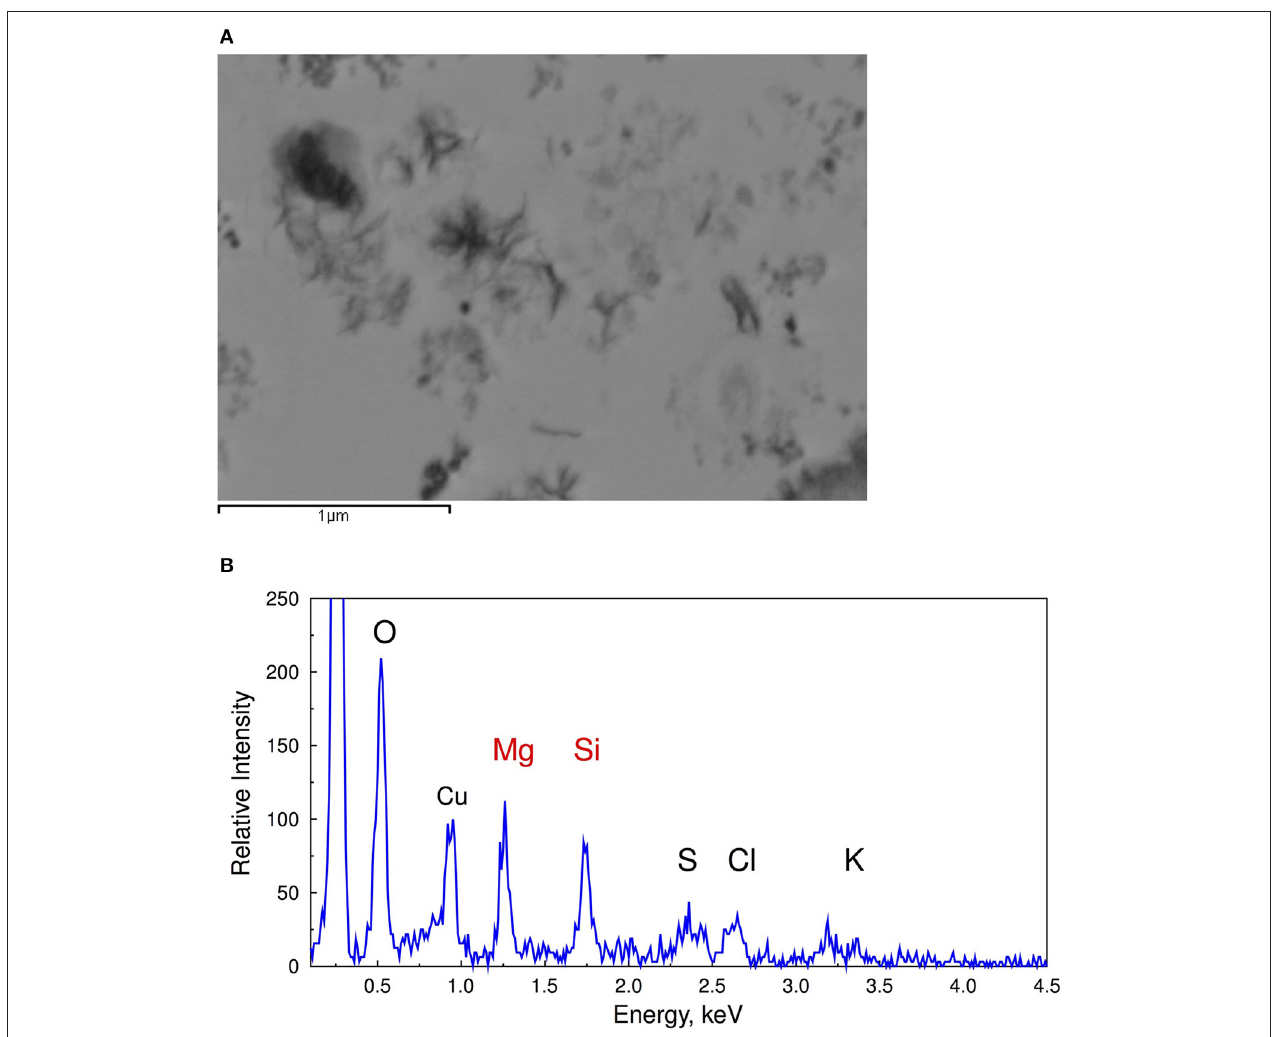
FIGURE 3 | Scanning transmission electron microscope images (A) and EDS spectra of decomposing Synechococcus cells (B) collected during dark incubation of cells after 15 days showing the association of silica with extracellular polymeric substance during the degradation of cyanobacterial cells (From Tang et al., 2014). Reprinted by permission from Macmillan Publishers Ltd: Tang et al. (2014). Copyright ©